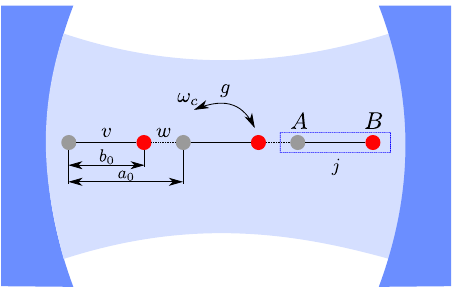
Fig. 1 Scheme of the Su-Schrieffer-Heeger chain coupled to cavity. A one- dimensional dimerized Su-Schrieffer-Heeger chain with intracell v (black solid line) and intercell w (black dashed line) hopping amplitudes coupled to a single mode cavity with frequency ω c . The strength of the light-matter coupling is given by g . The lattice constant is a 0 , and the distance between the sublattices A and B within the same unit cell (blue dashed square) is b 0